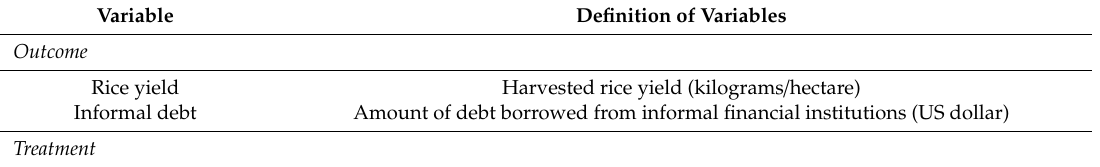
Table 1. Description of